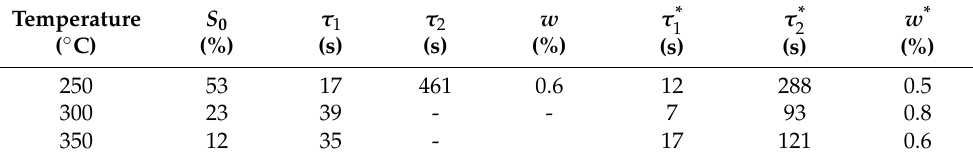
Table 1. Results of the fitting procedure for the response and recovery transients at various tempera- tures and a fixed concentration of NO (500